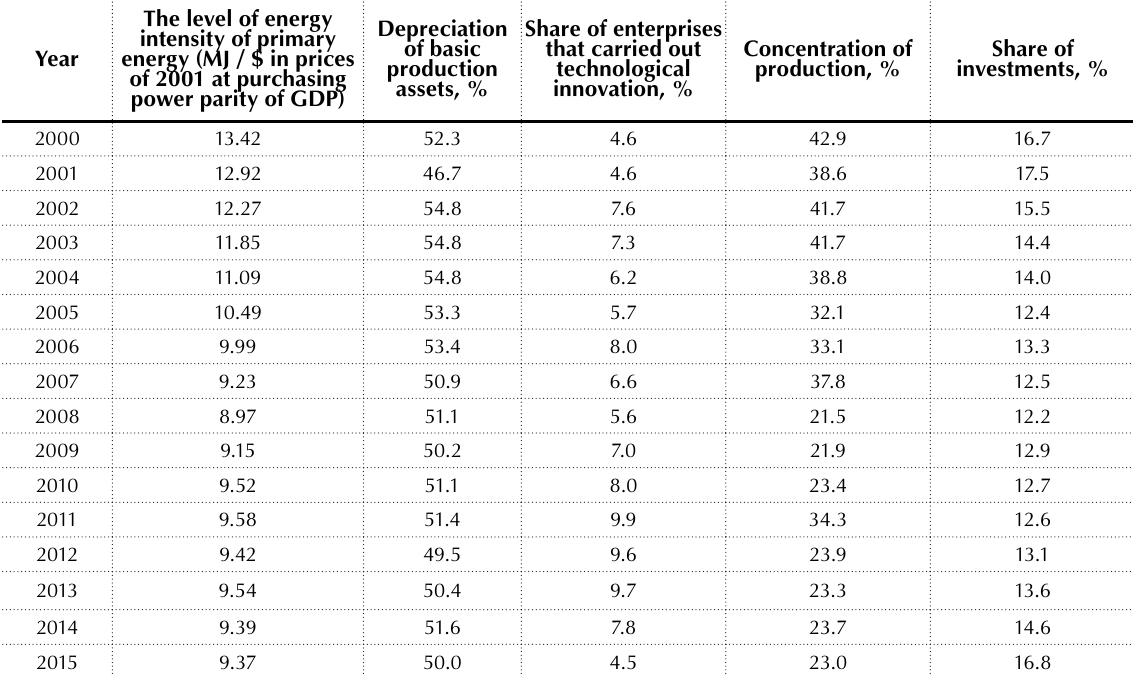
Table 2. Initial data for the regression